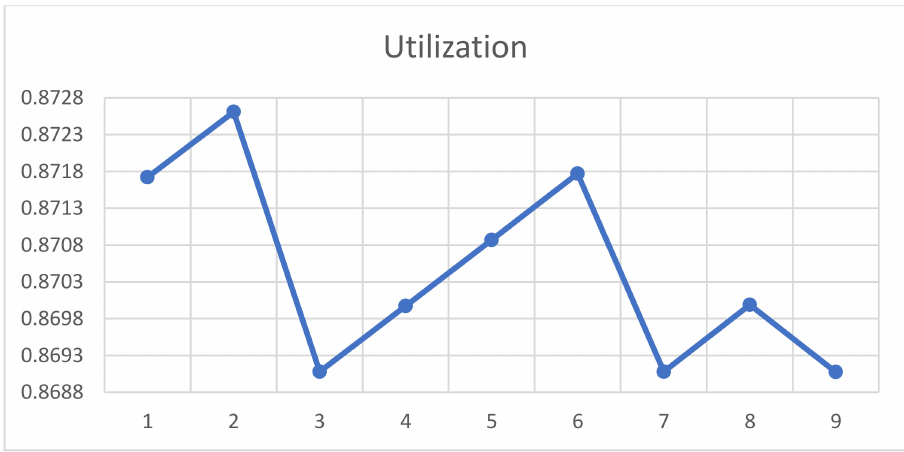
Figure 9. Utilization for the top nine portfolios in the baseline case.